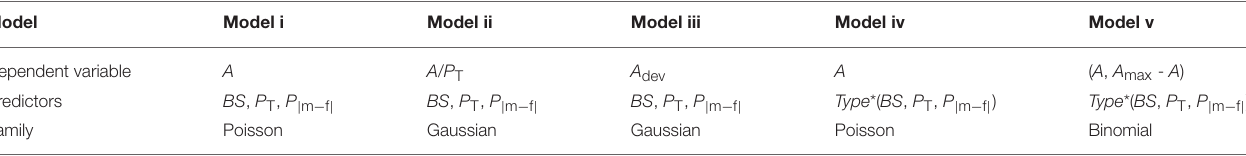
TABLE 2 | Model structure for the 5 candidate models to analyze